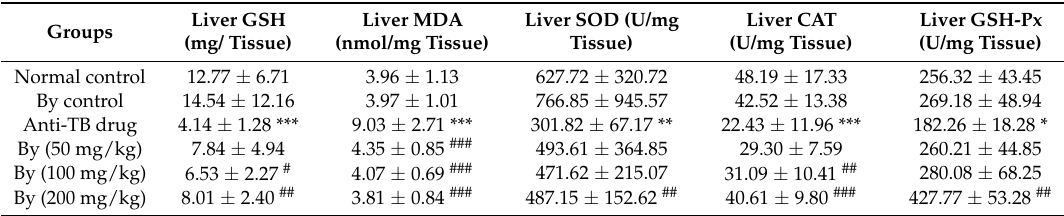
Table 1. Influence of bicyclol on liver GSH, MDA contents, and SOD, CAT, and GSH-Px activities in anti-TB drug-intoxicated rats.